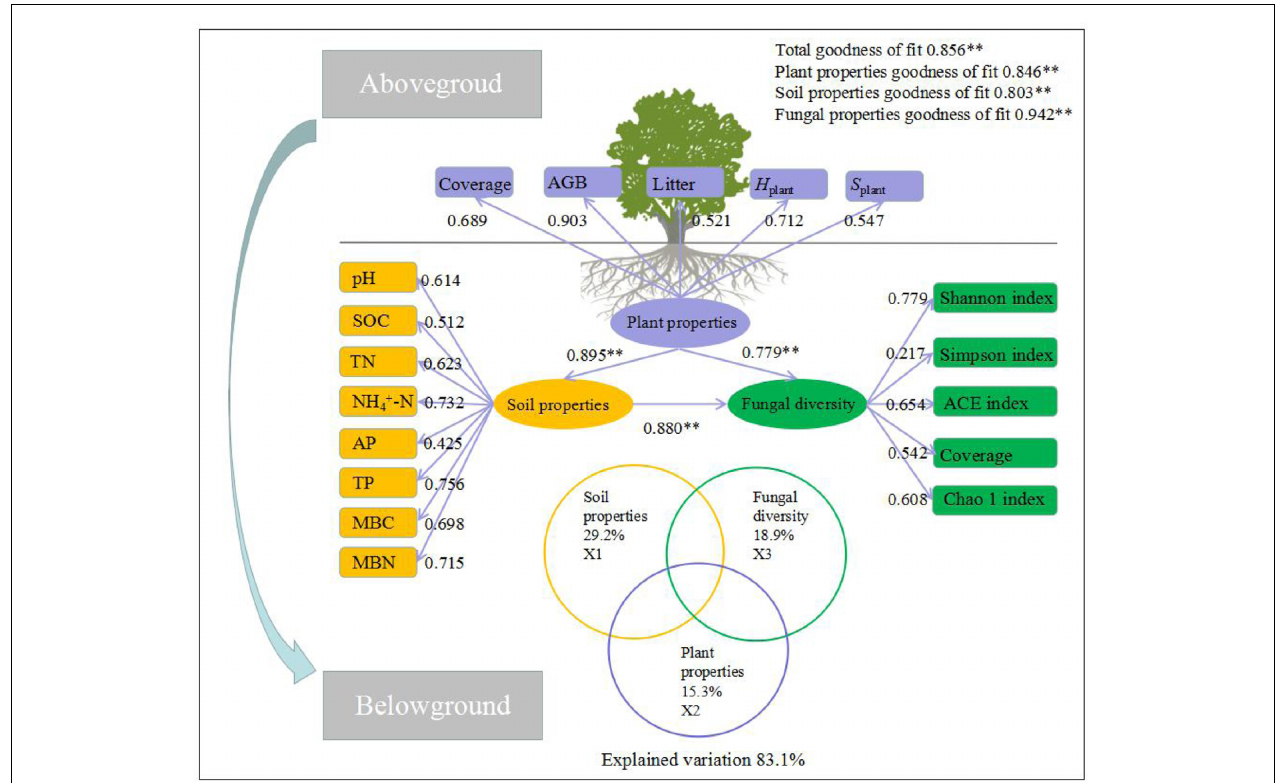
FIGURE 5 | Structural equation model (SEM) among the plant and soil properties and fungal diversity. The standardized coefficient is given for the SEM. Values in rectangular frames denote the measurable properties. Values in ellipsoidal frames denote plant properties, soil properties and fungal diversity. The goodness of fit was greater than 0.8 for the SEM and the results of the generalized additive models (GAMs). The GAM analyses led to the following fractions: pure effect of soil properties (X1); pure effect of plant properties (X2); pure effect of fungal diversity (X3) (including the main phyla with relative abundance higher than 4%); and explained variation. The path coefficients and the explained variability were calculated after 999 bootstraps. Models with different structures were assessed using the goodness of fit statistic, a measure of the overall prediction